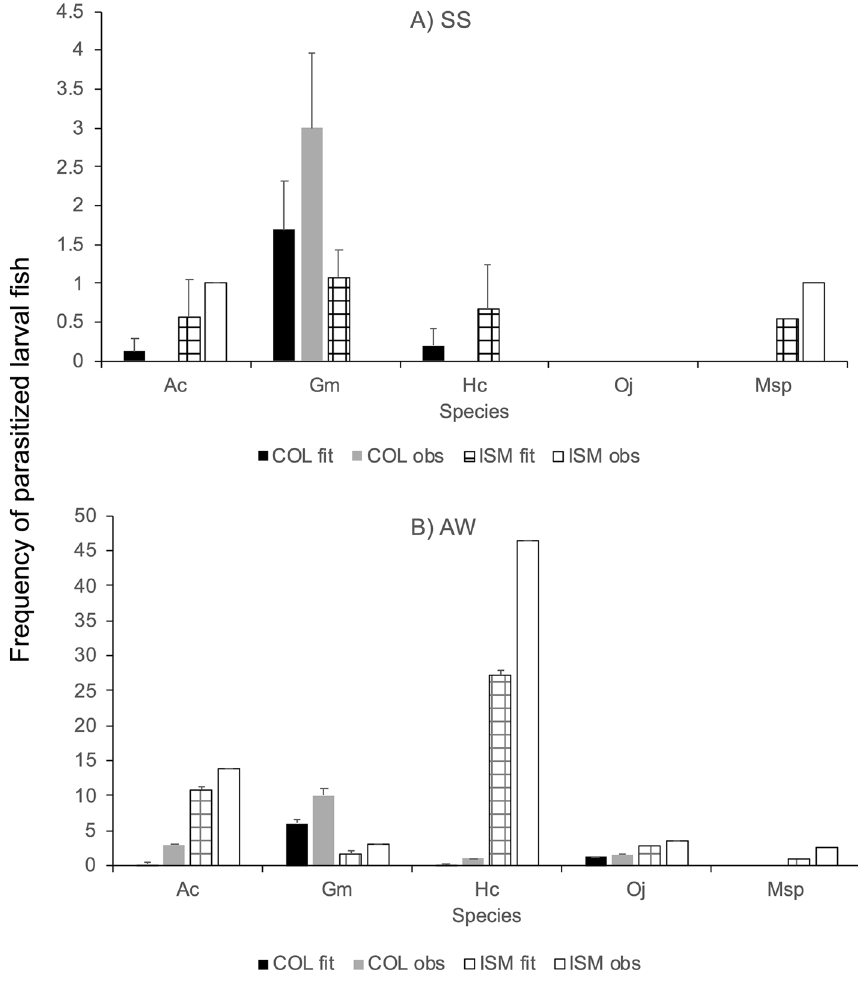
Figure 5. Observed and predicted frequency of parasitized fish larvae on 5 fish species in two areas during seasons. ( A ) SS (spring–summer) and ( B ) AW (autumn–winter). Error bars show the standard error. Ac, Auchenionchus crinitus ; Gm, Gobiesox marmoratus ; Hc, Helcogrammoides cunninghami ; Msp, Myxodes sp.; Oj, Ophiogobius jenynsi